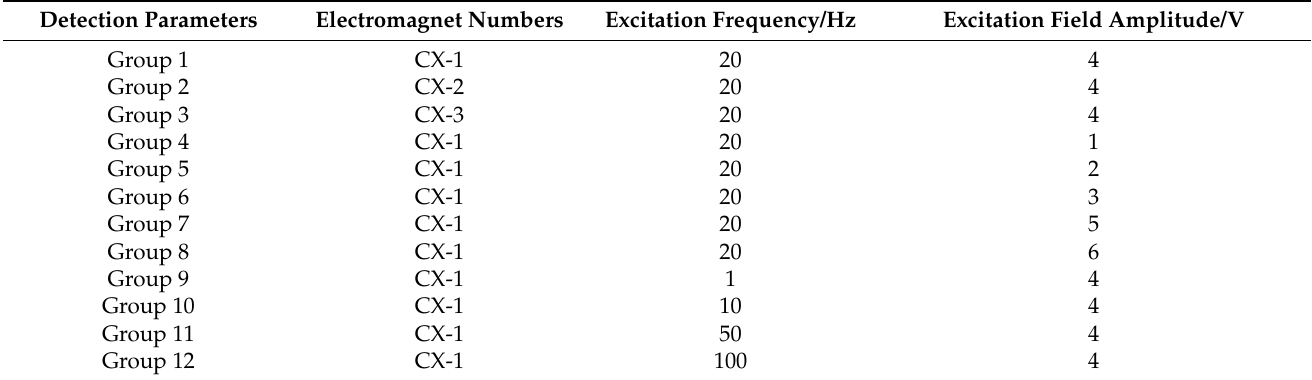
Table 2. Detection parameters.